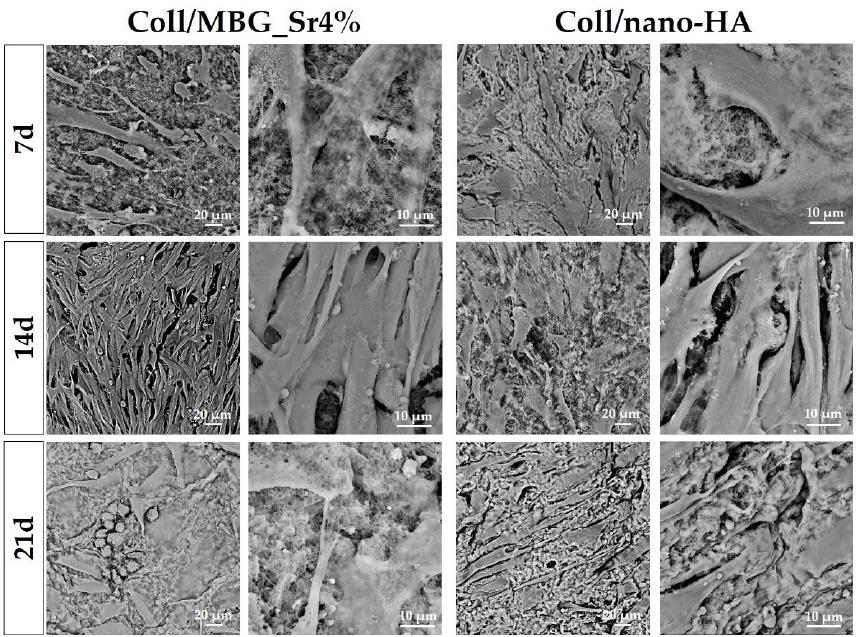
Figure 8. SEM micrographs of OB adhesion on Coll/MBG_Sr4% and Coll/nano-HA composite systems at the considered timepoints.